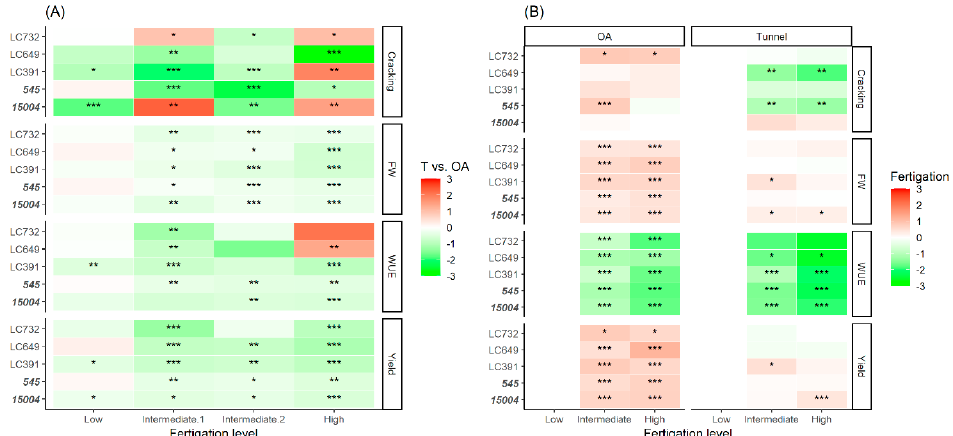
Figure 4. Environmental effects on yield related traits in Penjar tomato landraces (LC732, LC649, LC391) and modern varieties (545, 15004, marked in bold). ( A ) Effect of cultivation under tunnel (T) in comparison with cultivation in open air (OA) conditions, across increasing fertigation regimes. Color scale in heatmap represent the log2-transformed ratio of trait value in T respect to OA. Intermediate.1 and Intermediate.2 refers to two comparisons in the intermediate (75% ETc) range of fertigation. ( B ) Effect of intermediate (75% ETc) and high (120% ETc) fertigation in comparison with low fertigation regimes (25% ETc) under OA and T environments. Color scale in heatmap represent the log2-transformed ratio of trait value at each fertigation respect low fertigation regimes. FW: fruit weight; WUE: water-use efficiency. Level of significance: * p < 0.05; ** p < 0.01; *** p < 0.001; empty when not significant ( p > 0.05).